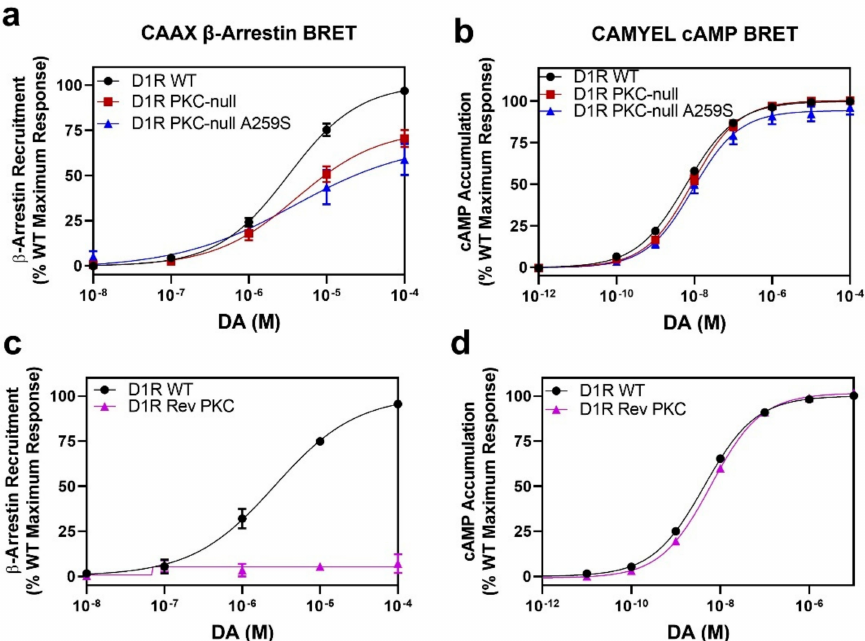
Figure 8. D1R residues phosphorylated by PKC have small but significant effects on DA-induced β -arrestin recruitment. CAAX β -arrestin recruitment and CAMYEL cAMP accumulation assays were performed as described in Section 4. ( a ) A “PKC-null” D1R in which residues S11–14 in the C-terminus and S4 in the ICL3 were simultaneously mutated to alanines displays a significant decrease in DA-induced β -arrestin recruitment: D1R WT EC 50 = 3.4 ± 0.5 µ M, Emax = 100%; D1R PKC-null EC 50 = 4.5 ± 1.5 µ M, Emax = 71 ± 3.5% ***. Reintroduction of serine S4 (S259) in the PKC-null mutant does not change DA-induced β -arrestin recruitment: D1R PKC-null + A259S EC 50 = 3.2 ± 1.7 µ M, Emax 59 ± 9.4% ****. ( b ) The PKC-null and PKC-null + A259 constructs display normal G protein signaling: D1R WT EC 50 = 5.9 ± 0.7 nM, Emax = 100%; D1R PKC-null EC 50 = 9.9 ± 1.5 nM, Emax = 101 ± 1.6%; D1R PKC-null A259S EC 50 = 10 ± 1.6 nM, Emax 94 ± 4.4%.